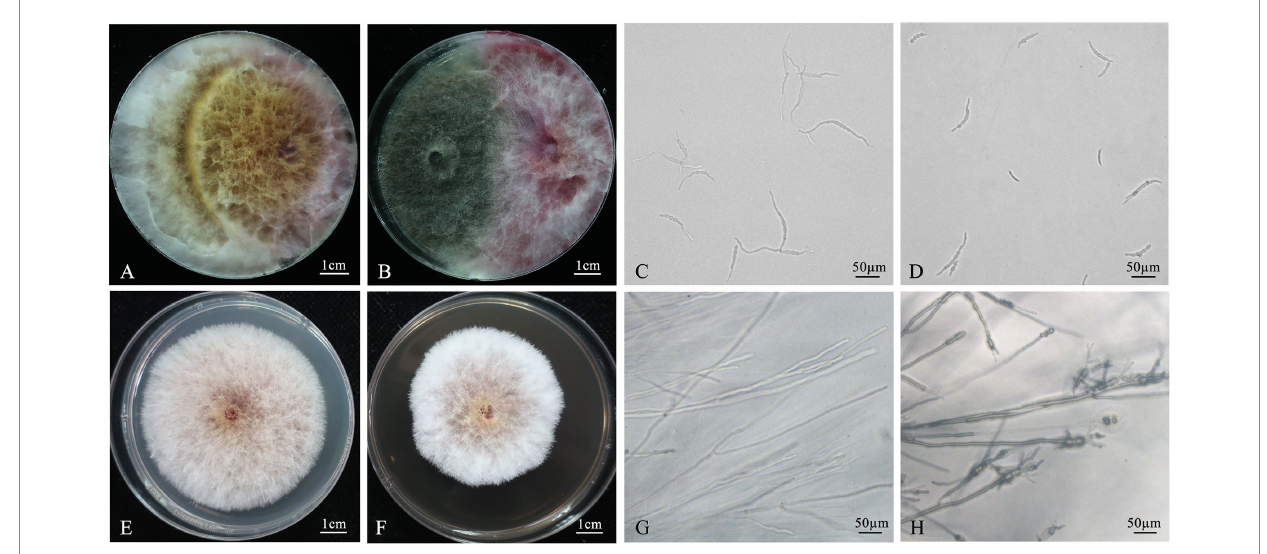
FIGURE 1 Inhibition effect of Chaetomium globosum 12XP1-2-3 against Fusarium pseudograminearum . (A , B) Tablet antagonism of C. globosum 12XP1-2-3 against F. pseudograminearum . (A) Control; (B) Treatment; (C, D) Inhibition effect of C. globosum 12XP1-2-3 fermentation broth on spore germination of F. pseudograminearum . (C) Control; (D) The fermentation-broth-treated group; (E, F) Inhibition effect of C. globosum 12XP1-2-3 fermentation broth on mycelial growth of F. pseudograminearum . (E) Control, (F) The fermentation-broth-treated group; (G, H) Microscopic observations of hyphae edge from (E) and (F) ,